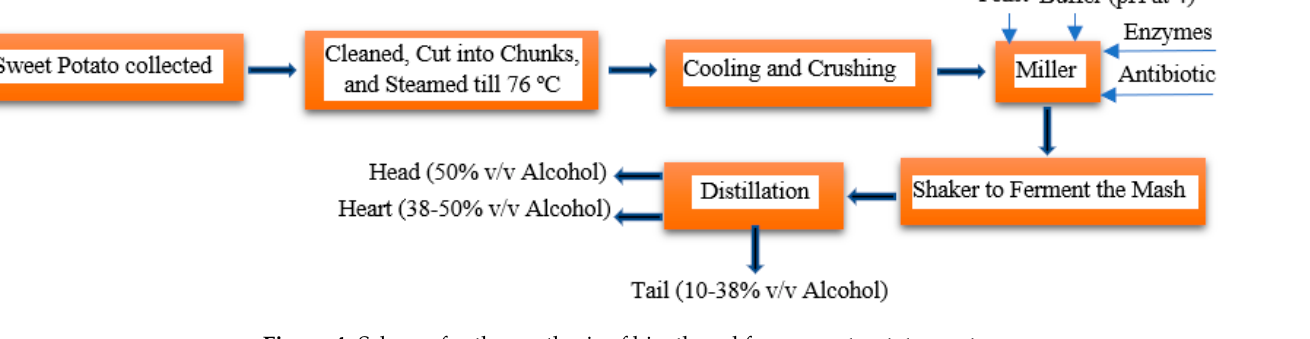
Figure 4. Scheme for the synthesis of bioethanol from sweet potato waste. Table 2. Combustion emissions reduction of cashew nutshell biodiesel in comparison with conven- tional diesel fuel